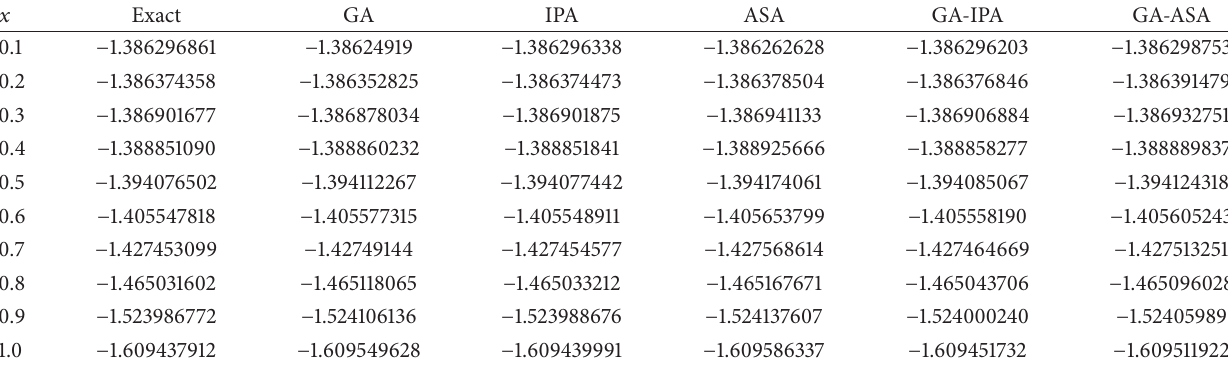
Table 11: Approximate numerical results of Example 3 (for 𝑚 = 0.25 ) by the proposed method.